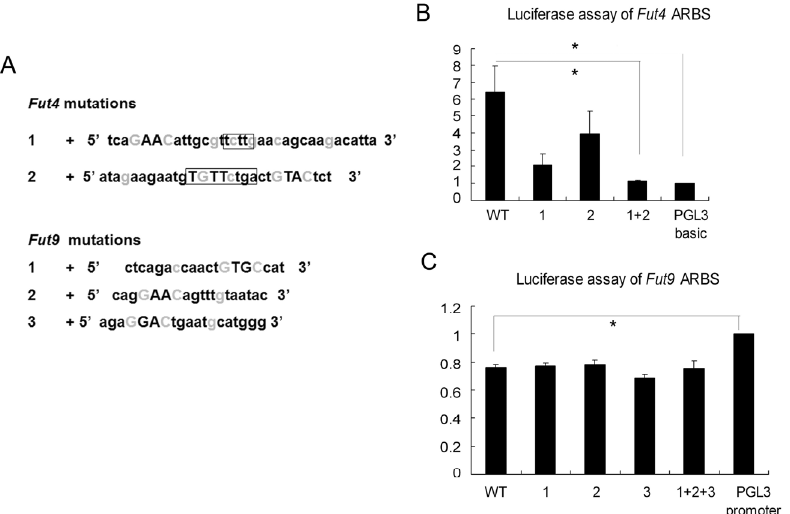
Figure 4. ( A ) The sequences and mutations of ARBSs of Fut4 and Fut9. The key G/Cs in light gray were mutated to A/Ts. Capitalized letters indicate conserved core binding elements. In Fut4 , the repeat sequences shared by the tandem ARBSs were labeled with boxes. Luciferase assay of ( B ) Fut4 ARBSs and ( C ) Fut9 ARBSs in response to the androgen stimulation. Data are expressed as the mean ± SEM ( n = 3), * p < 0.05, as compared with the corresponding